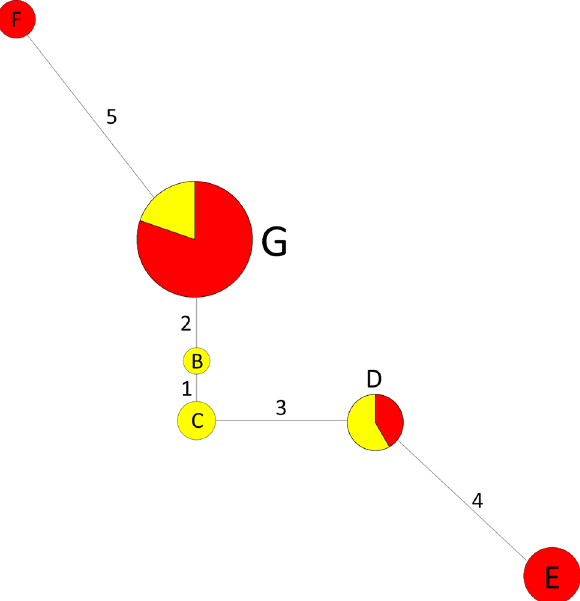
Fig 3. Chlorotype median network showing six chlorotypes identified in Ziziphus jujuba and Z . acidojujuba based on stepwise differences of five cpSSR loci. The circle size indicates the chlorotype frequency in 95 samples of Z. jujuba and Z. acidojujuba, the red color in the pie chart shows the proportion of jujube, and the yellow color shows the proportion of wild jujube. Number on the branch nodes represent the mutation steps based on the difference in the repeat number of cpSSR loci. One wild jujube individual in B, 2 wild jujube individuals in C, 5 jujube cultivars and 7 wild jujube individuals in D, 12 jujube cultivars in E, 2 jujube in F; 53 jujube and 13 wild jujube in